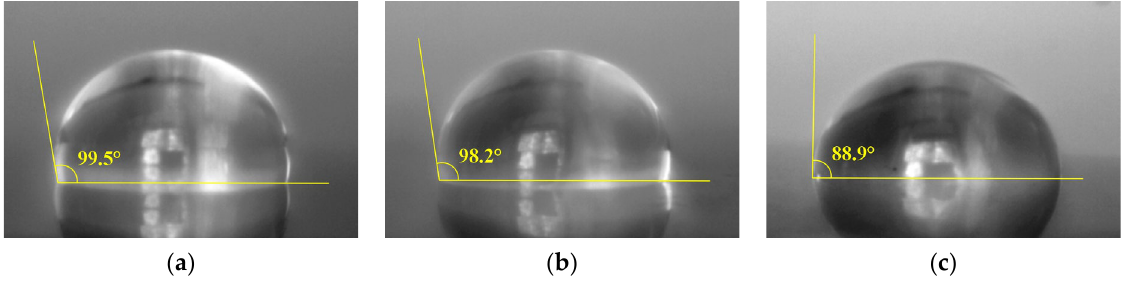
Figure 14. Water contact angle test for the deposited layer when using DC power supply for the deposition times of ( a ) 5 min, ( b ) 10 min and ( c ) 15 min.